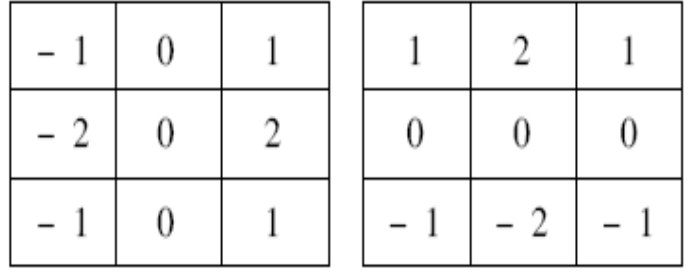
Figure 3. Sobel Figure 3. Sobel operator.